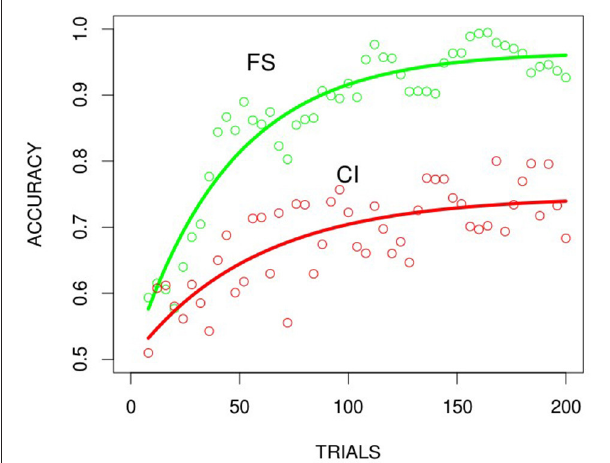
FIGURE 3 | Human behavioral results for the 2D binary Kruschke (1993) stimuli for the FS and the CI conditions. Data fit with Equation 2: neg-exp (red FS and green CI). Data are binned (every 4 trials) and plotted at midpoints of each